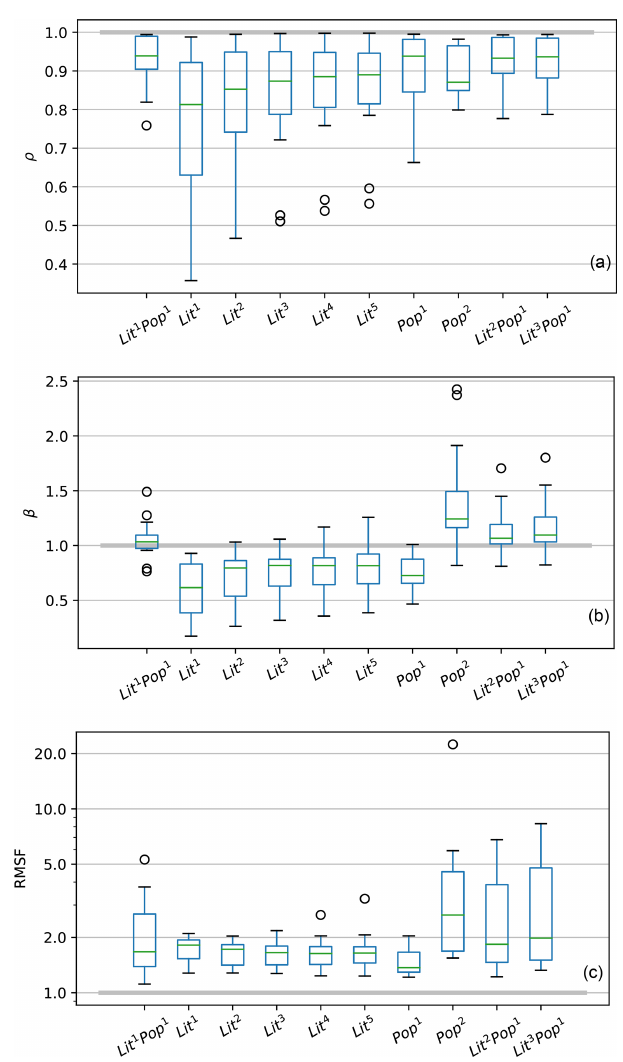
Figure 3. Box plots showing the skill metrics ρ (a) , β (b) , and RMSF (c) for variations in Lit m Pop n . The metric value of 1, indi- cating perfect skill, is demarcated by the solid grey line. The plots are based on data from 14 countries and show the median (green), the first and third quartiles (IQR, blue box), data points outside the IQR but not more than 1 . 5 · IQR distance from either the first or the third quartile (black whiskers), and outliers (black circles). RMSF is plotted on a logarithmic scale. Underlying metric values per country are listed in Table A2. Median and IQR per skill metric and combi- nation of exponents are shown in Table